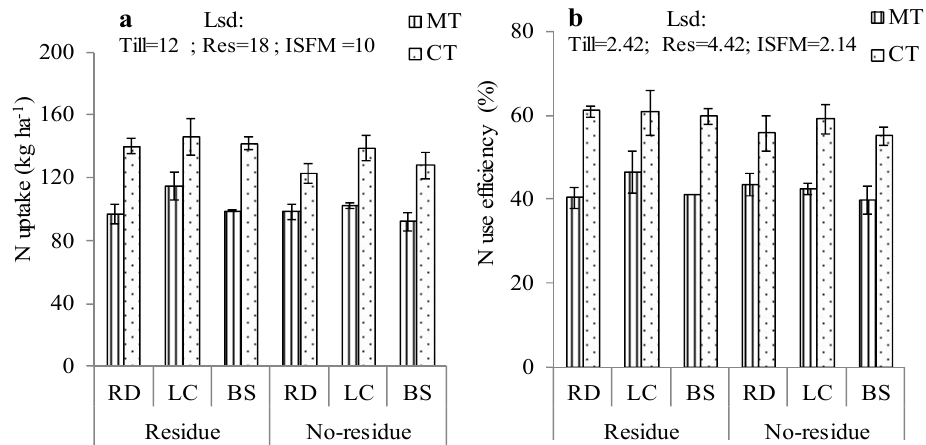
Figure 4. Management impacts on N uptake and N-use efficiency (NUE) for two consecutive years ( a ) 2017 and ( b ) 2018 .